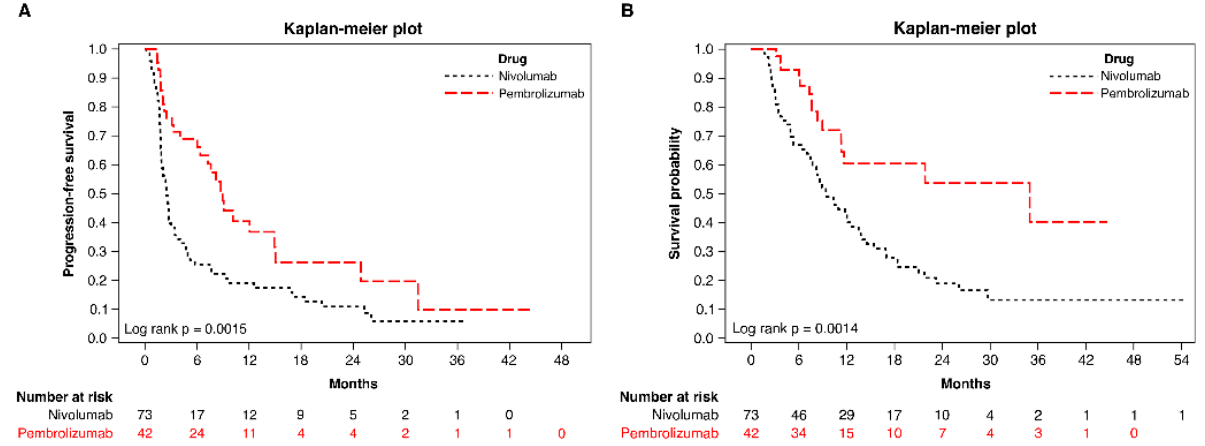
Figure 2. Progression-free survival ( A ) and overall survival ( B ) of patients treated with nivolumab or pembrolizumab.